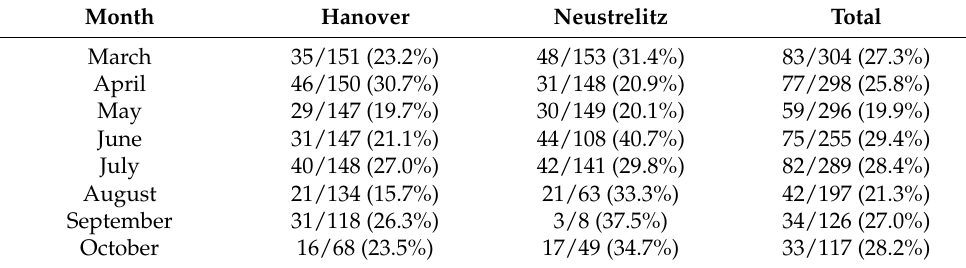
Figure 1. Distribution of the morphometric age ratio and Borrelia prevalence in the dataset of 1882 I. ricinus ticks. Percentages indicate the Borrelia prevalence in each category. Table 3. Monthly Borrelia spp. prevalence in questing I. ricinus nymphs.